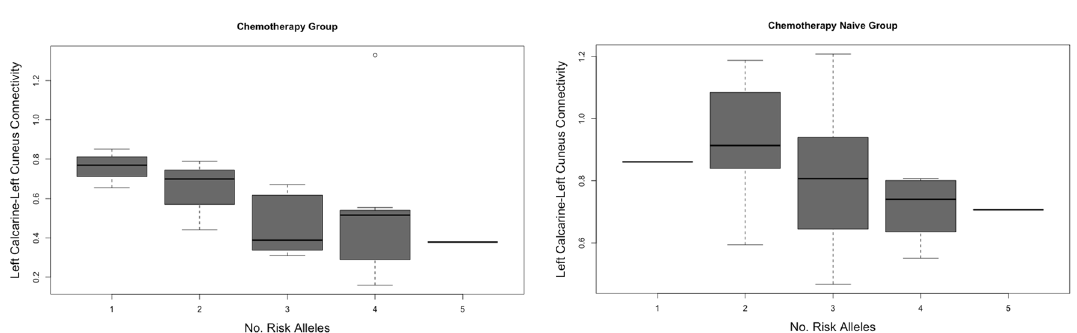
Figure 3. Correlation between left calcarine-left cuneus connectivity and number of risk-related alleles in the breast cancer